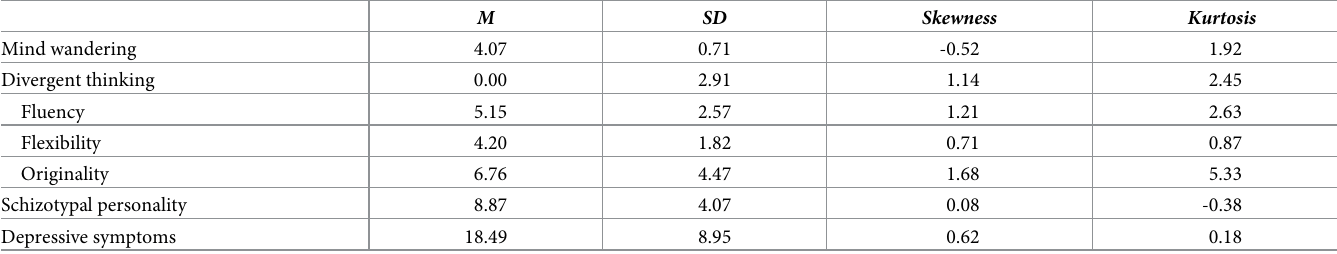
Table 1. Means and standard deviations of variables.